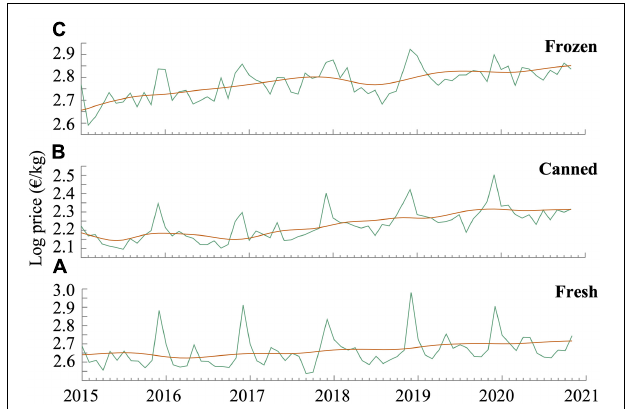
FIGURE 7 | Price (€/kg in log) on (A) fresh, (B) canned, and (C) frozen products (includes fish, mollusks and crustaceans) in Galicia. Monthly evolution of price (green) and trend (orange) were